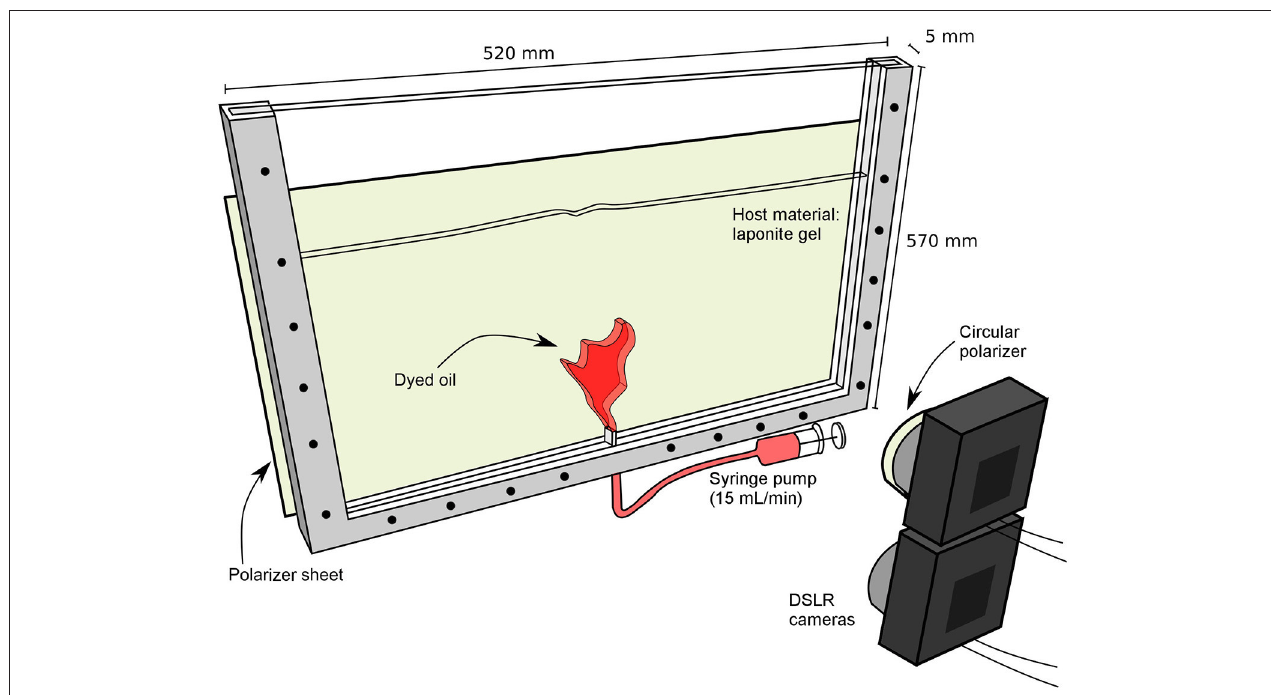
FIGURE 2 | Drawing of the experimental setup. A Hele-Shaw cell filled with a viscoelastic laponite gel is intruded by dyed olive oil. The cell is backlit with a diffused white light source. Intrusion flow rate is controlled with a syringe pump. The cell stands between a polarizer sheet and a circular polarizer mounted on the camera lense: strain-induced birefringence in the gel, as well as the gel/oil interface, is captured by the camera because the polarizers are crossed.